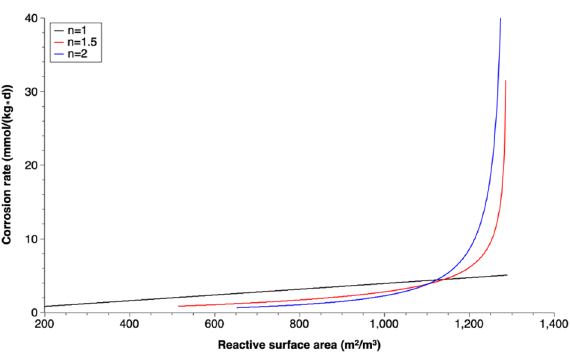
Figure 10. Corrosion rate versus reactive surface area with different coefficients of passivation